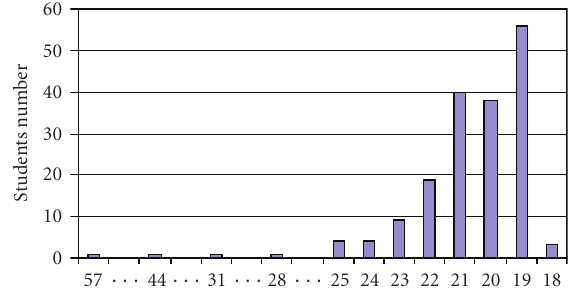
Figure 2: Age of students.